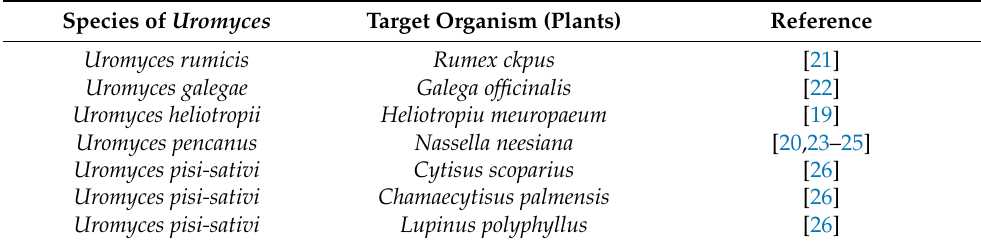
Table 1. List of species of Uromyces with biocontrol potential. Species of Uromyces Target Organism (Plants) Reference Uromyces